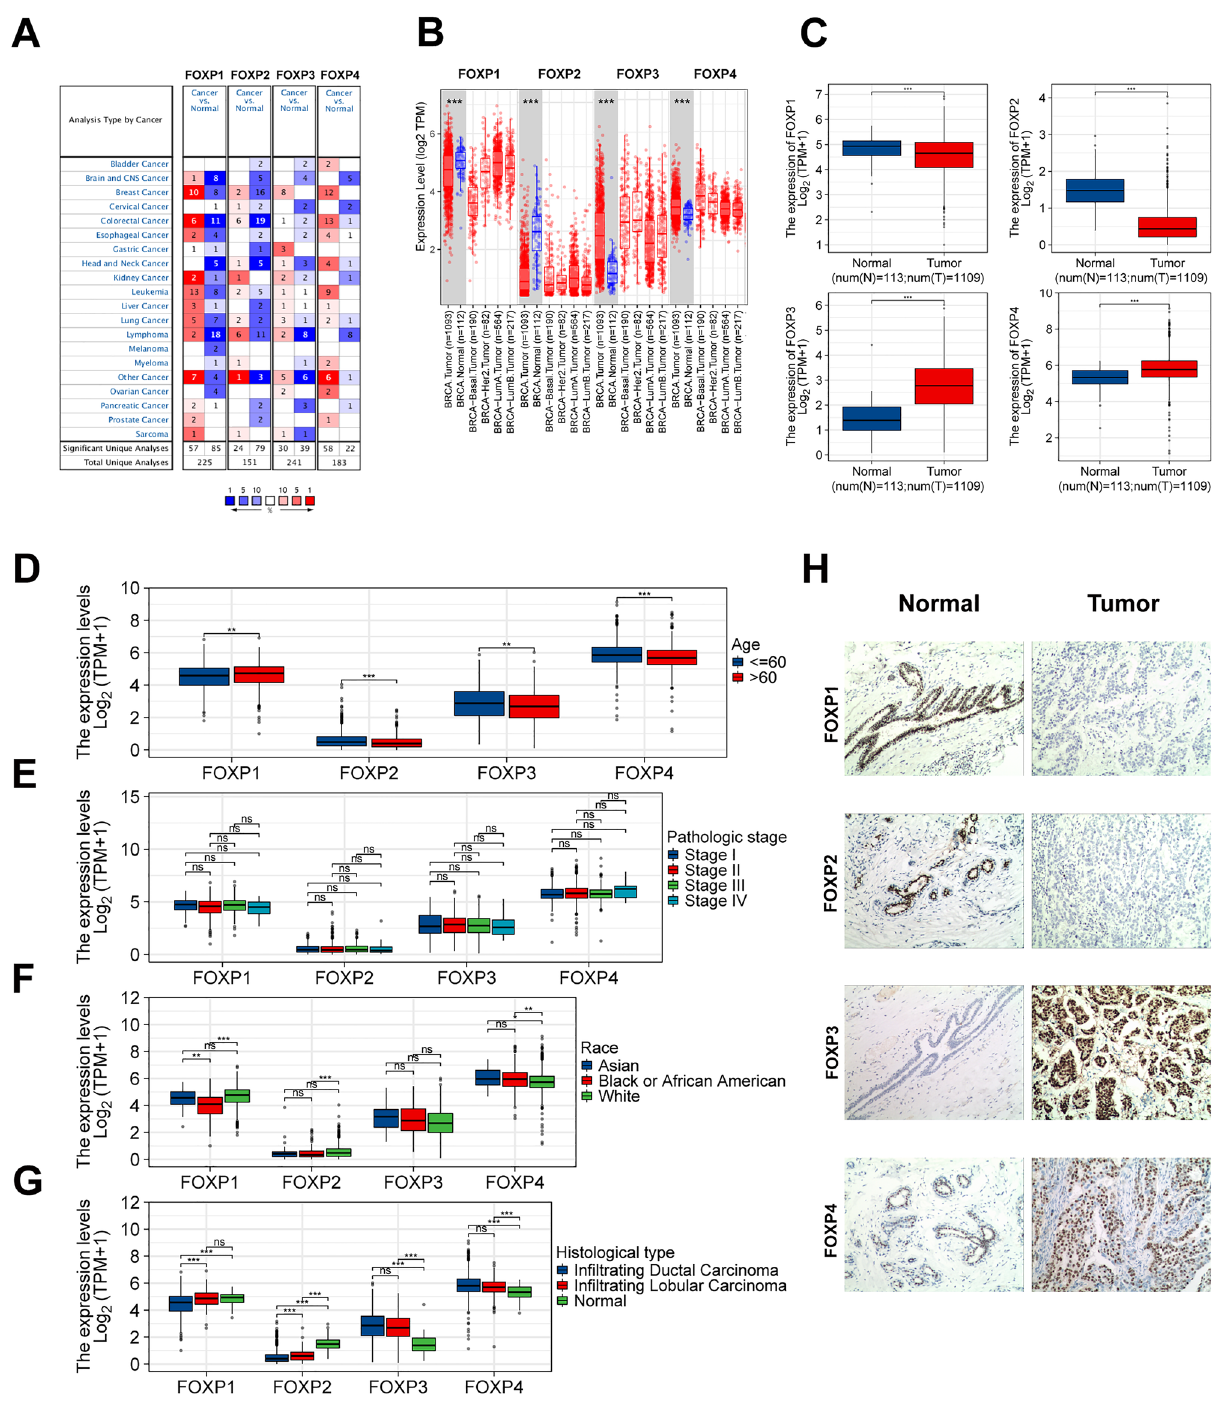
Figure 1. FOXPs expression levels, clinical characteristics and immunohistochemistry in human cancer. ( A ) The transcription levels of FOXPs in different types of cancers (Oncomine). ( B ) Human FOXPs expression levels in human BRCA from TCGA database were determined (TIMER). ( C ) The mRNA expression levels of FOXPs in 1109 BRCA samples and 113 normal samples from TCGA. ( D ) FOXP2,3,4 mRNA expression were significantly higher in patients (> = 60) than in patients (< 60), however the result was the opposite in FOXP1. ( E ) No statistically significant correlation were found between the expression levels of FOXPs in Pathologic stage. ( F ) The expression of FOXPs was different among different races. ( G ) FOXP1,2 mRNA expression were significantly higher in Infiltrating Lobular Carcinoma than Infiltrating Ductal Carcinoma, however no statistically significant correlation were found between FOXP3,4. ( H ) The Expression of FOXPs in BRCA (IHC) (ns, no significance, * P < 0.05, ** P < 0.01, *** P <